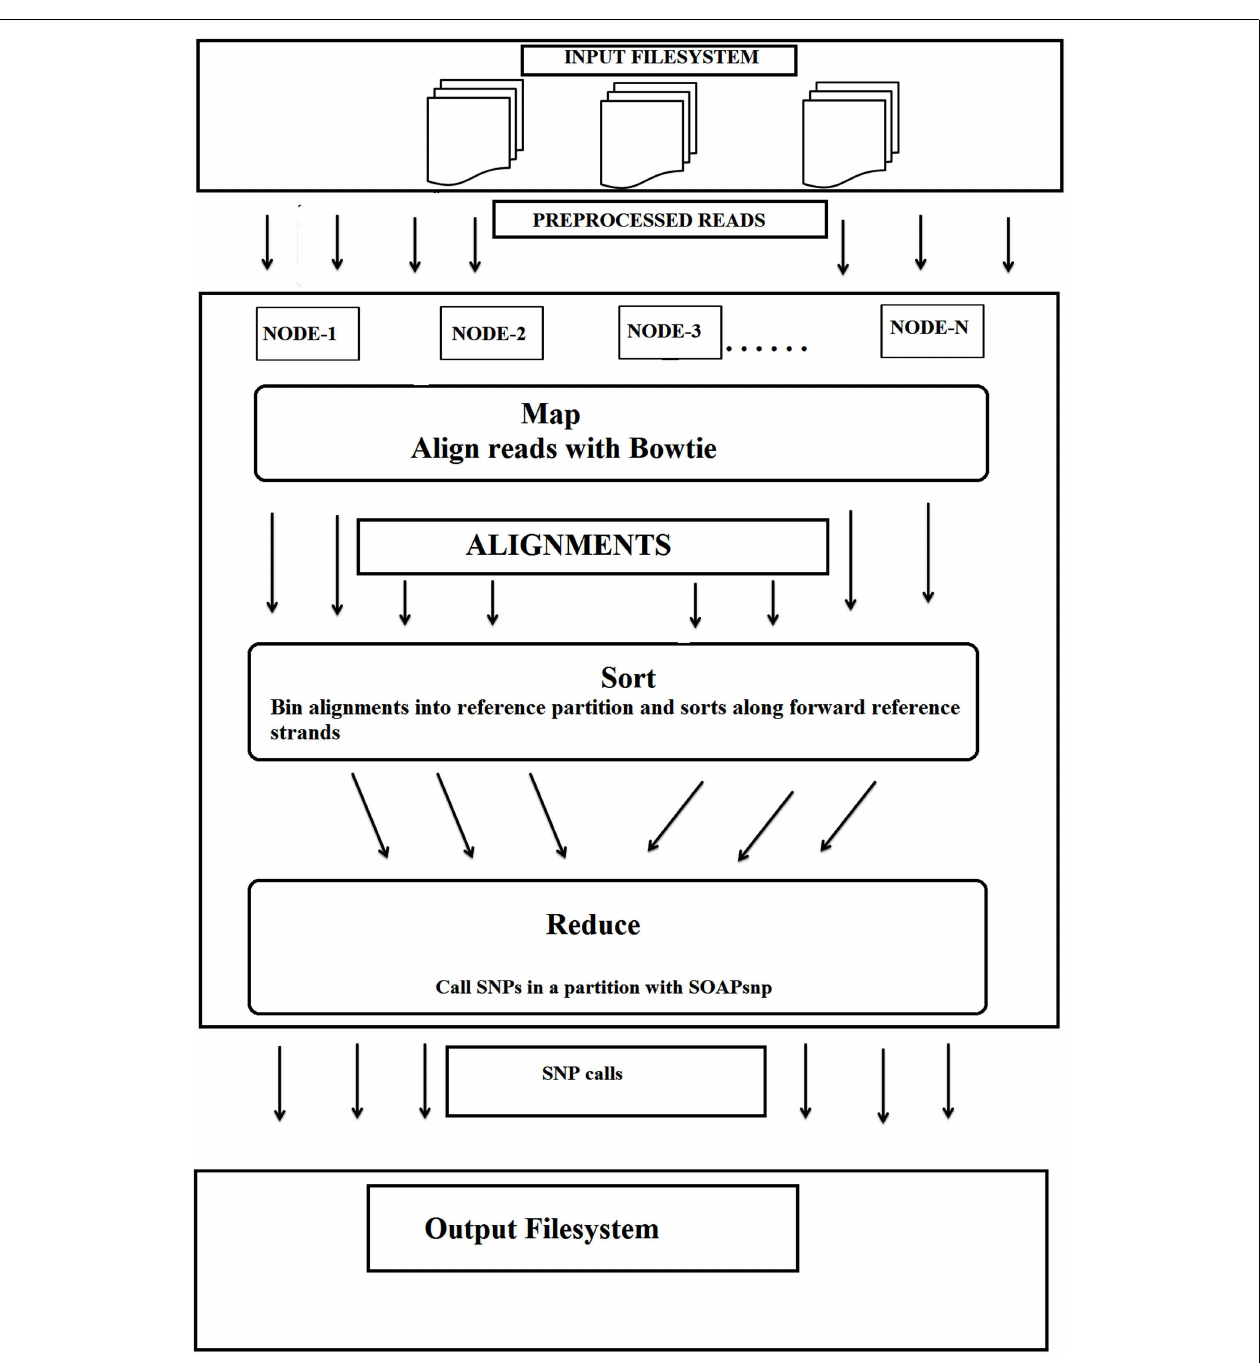
FIGURE 2 |The workflow for the detection of SNPs using cloud computing. Bowtie and SOAPsnp were used in this workflow (adopted from Langmead et al., 2009 with kind permission and slightly